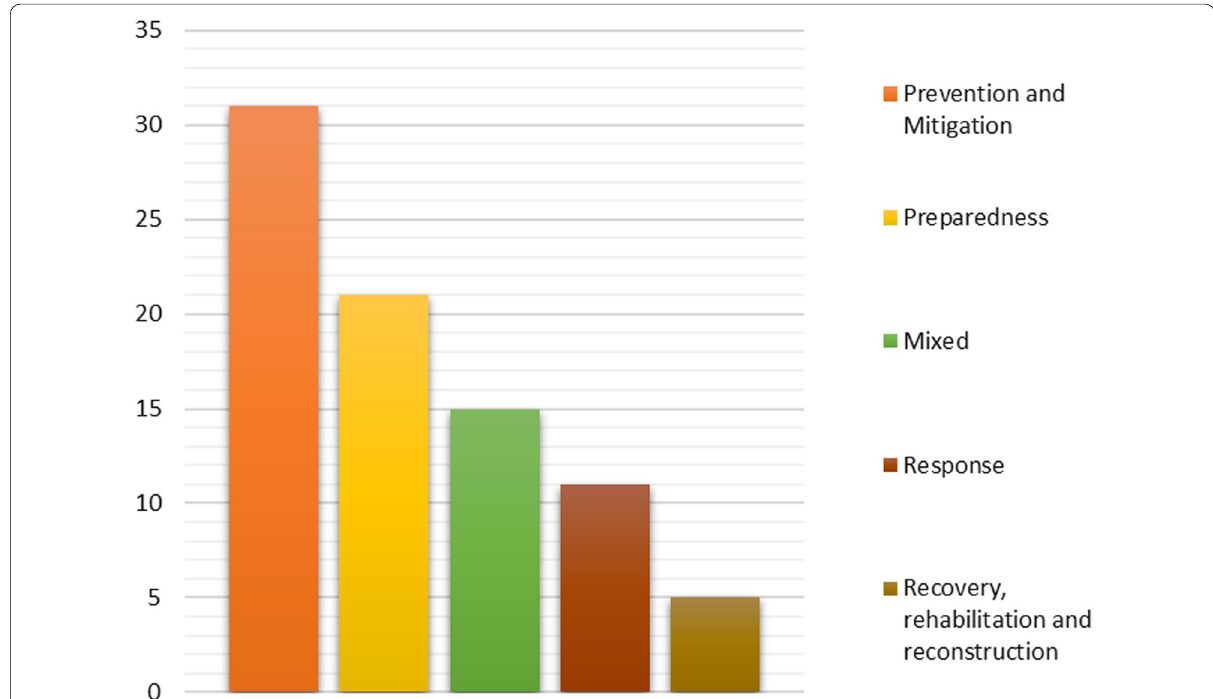
Fig. 4 Authors’ recommendations for disaster management. Source